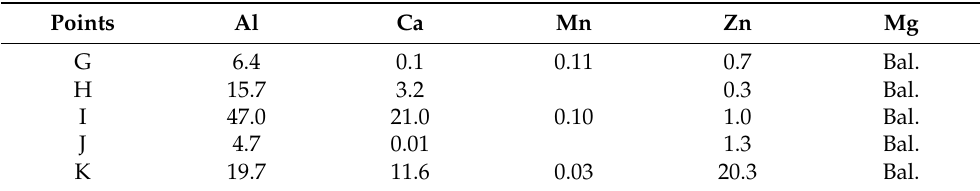
Figure 7. STEM images of homogenized ( a ) ZAXM2100 and ( b ) ZAXM4100 alloy sheets. Figure 8. Bright-field images of ( a ) homogenized and ( b , c ) peak-aged ZAXM4100 alloy sheets. The peak-aged ZAXM4100 alloy sheets are taken along the ( b ) [0001] tively.